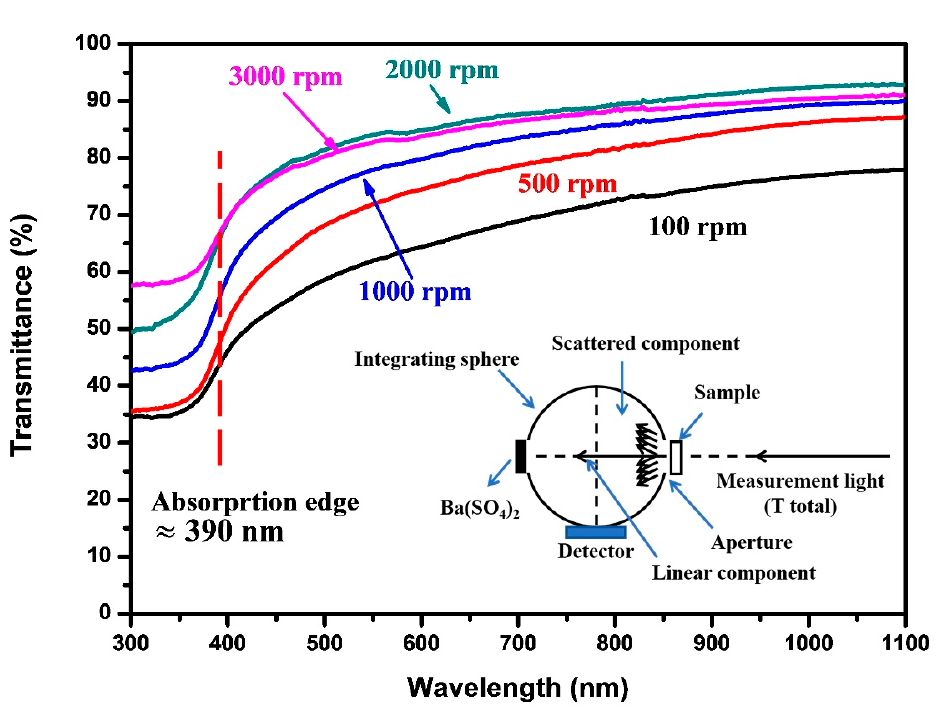
Figure 8. UV-Visible transmittance spectra of CuCrO 2 thin films annealed at 600 °C at different rotating speeds from 100 to 3000 rpm.